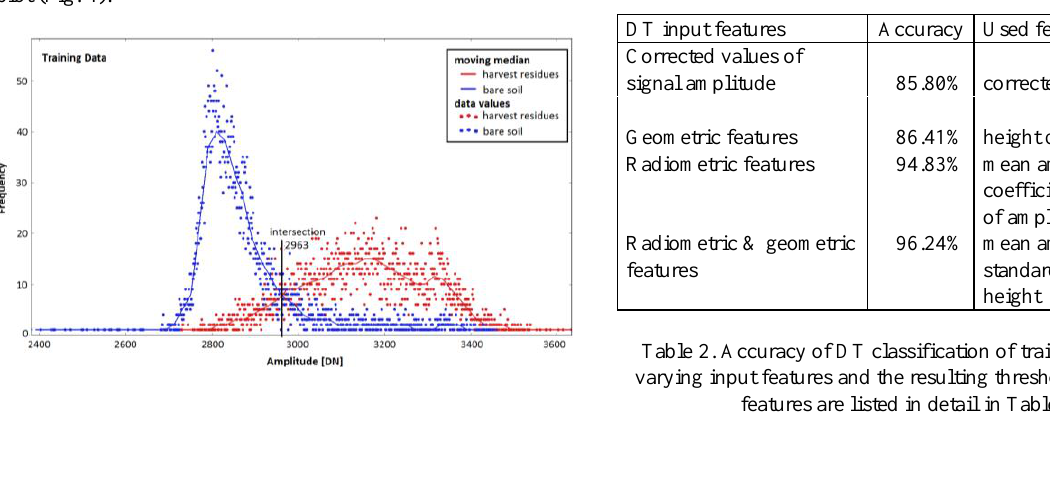
Figure 5. Derived classification tree of training data.